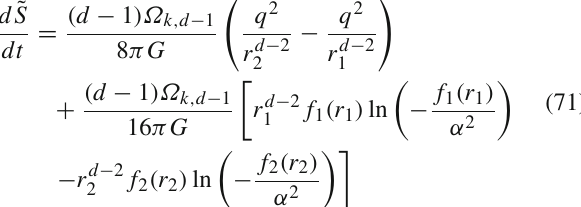
the process below the dashed line. Therefore, the complexity is given